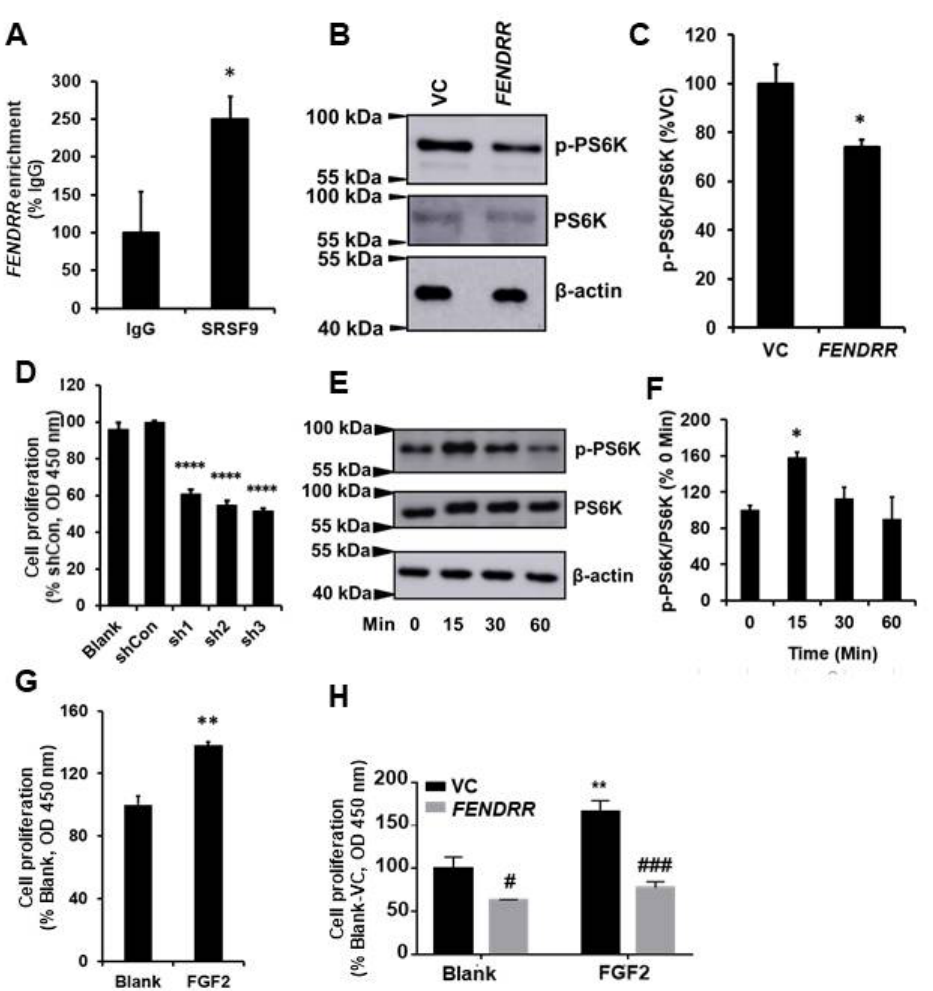
Figure 3. FENDRR reduces PS6K phosphorylation by binding SRSF9. ( A ) RNA immunoprecipitation showing the interaction of FENDRR with SRSF9 in LL29 cells. FENDRR enrichment was expressed as %IgG. ( B ) Western blot showing that FENDRR inhibits the phosphorylation of PS6K in LL29 stable cells expressing FENDRR or vector control (VC). ( C ) Quantitative analysis of protein levels of phosphorylated PS6K (p-PS6K). Values were normalized to total PS6K and then expressed as %VC. ( D ) Cell proliferation was determined by the BrdU assay at 6 days in LL29 cells infected with a lentivirus expressing a SRSF9 shRNA (MOI of 100 for 24 h). Values were expressed as %shCon. ( E ) Western blot showing the phosphorylation of PS6K at different times points (0, 15, 30, and 60 min) in LL29 cells treated with FGF2 (50 ng/mL). ( F ) Quantitative analysis of the phosphorylated PS6K and total PS6K protein levels from ( E ) . Values were normalized to total PS6K and then expressed as % 0 Min. ( G ) Fibroblast proliferation in LL29 cells treated with FGF2 (50 ng/mL) for 3 days as determined by the BrdU assay. Values were expressed as %Blank. ( H ) Fibroblast proliferation in LL29 stable cells expressing vector control (VC) or FENDRR treated with FGF2 (80 ng/mL) for 3 days was determined by the BrdU assay. Values were expressed as %VC of Blank. Values represent the means ± SE. n = 3 independent experiments. * p < 0.05 vs. IgG, VC, or 0 min, ** p < 0.01 vs. Blank, **** p < 0.0001 vs. shCon, # p < 0.05 and ### p < 0.001 vs VC. Student’s t-test for ( A, C, G ); one-way ANOVA and Tukey’s multiple comparison for (D, F ); and two-way ANOVA and Tukey’s multiple comparison for ( H ).